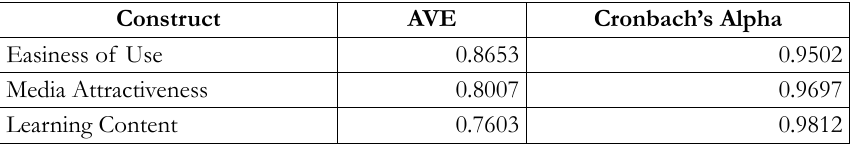
Table 3. The AVE & Cronbach’s Alpha of Signal Coding Technique simulation